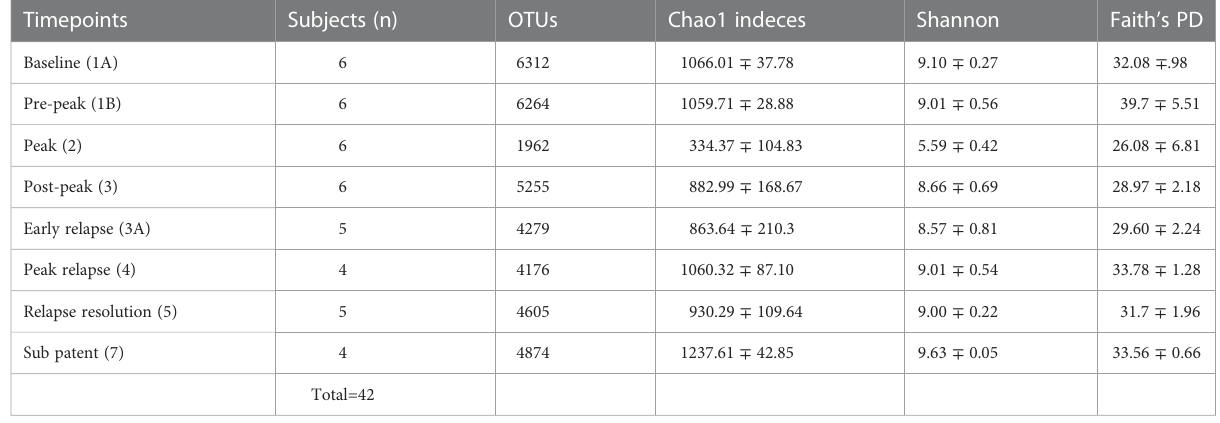
TABLE 1 Fecal microbiota community indices for all rhesus macaque subjects at seven different TPs during the longitudinal study of P. cynomolgi infection.